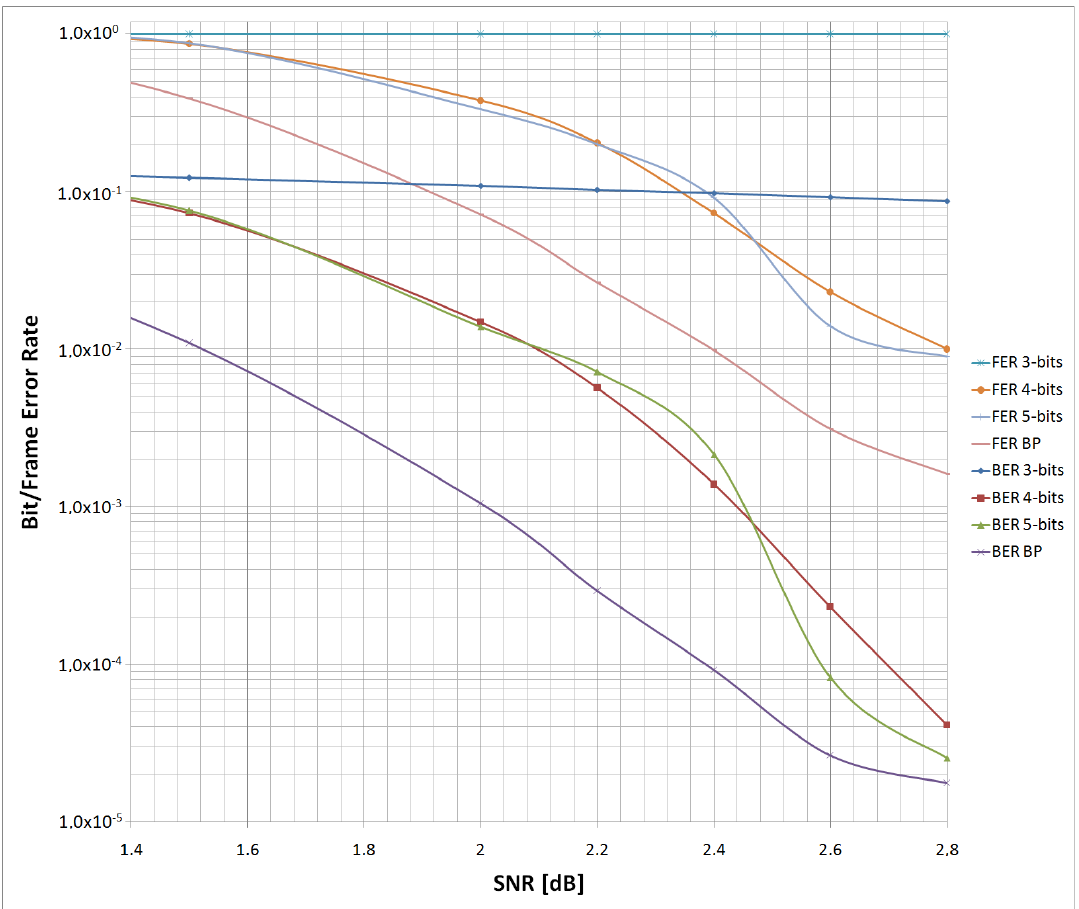
Figure 12. BER and FER chart for QC-LDPC decoder depending on data bus